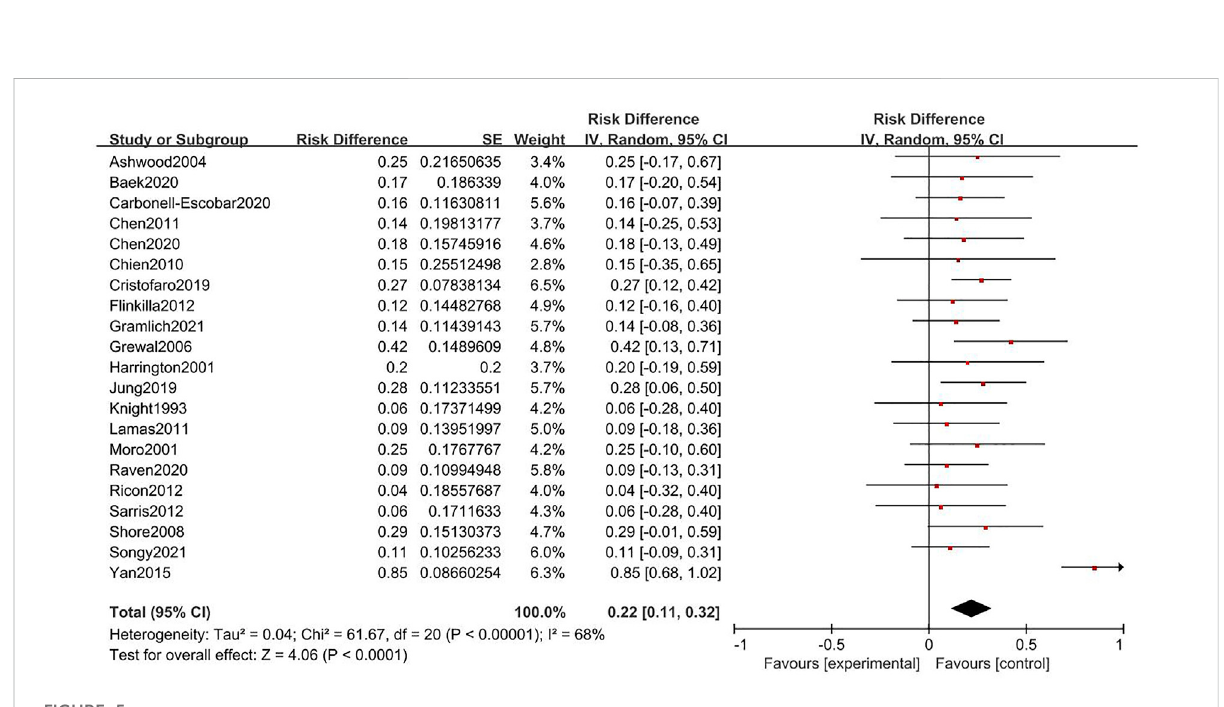
FIGURE. 5 Forest plot for rate of complication of uncemented fi